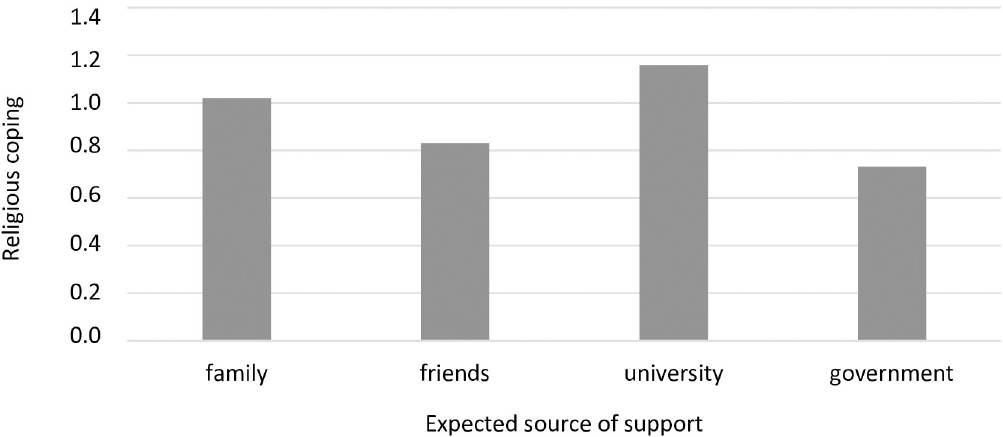
Fig 7. Students’ use of religious coping (mean) and sources of expected support during the COVID-19 pandemic (F = 3.99, p = 0.007, η 2 = 0.02).